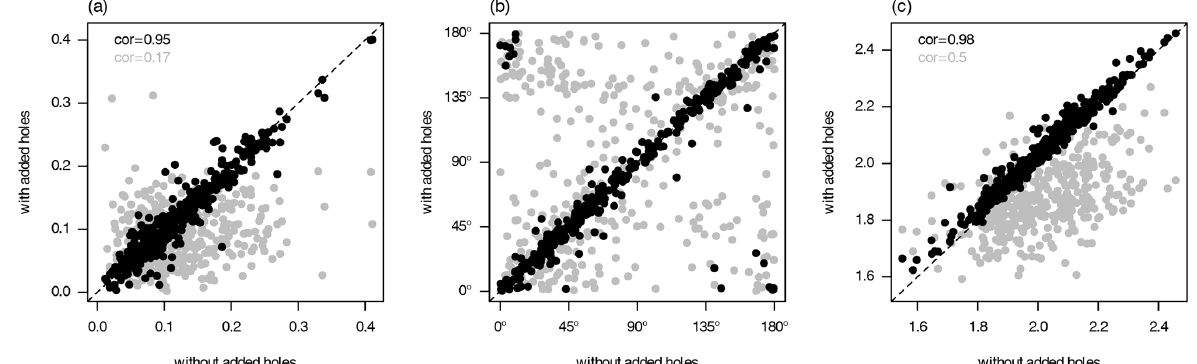
Figure B1. Anisotropy ρ (a) , angle ϕ (b) , and scale z (c) estimated from nearly complete images ( x axis) and images with added holes ( y axis). Black dots show the results of the iterative gap-filling algorithms; values obtained without gap filling are shown in grey. Correlations between the x and y values are shown in the top left corner for both estimates in the corresponding color. Linear correlations are not helpful for the circular quantity in panel (b) and were thus